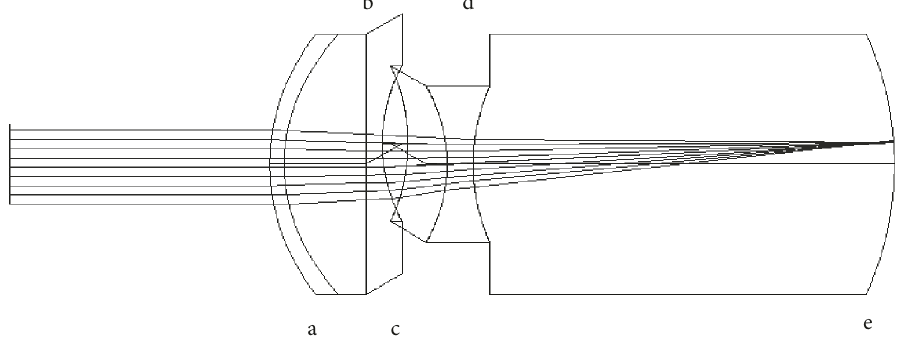
Figure 4: ITS 2 with decentered anterior lens. a, cornea; b, pupil; c, anterior positive lens; d, posterior positive lens; e, retina.